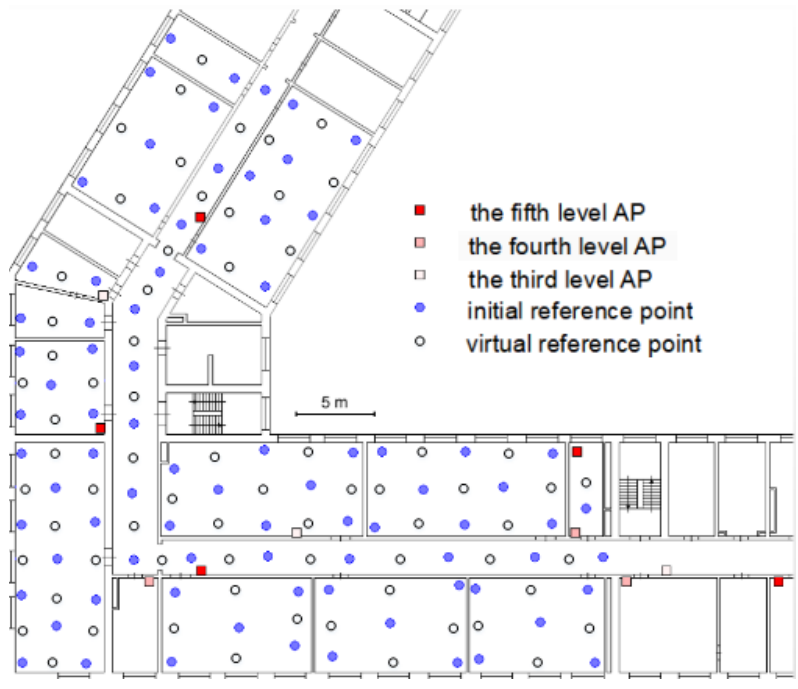
Figure 5. Layout of experiment context.